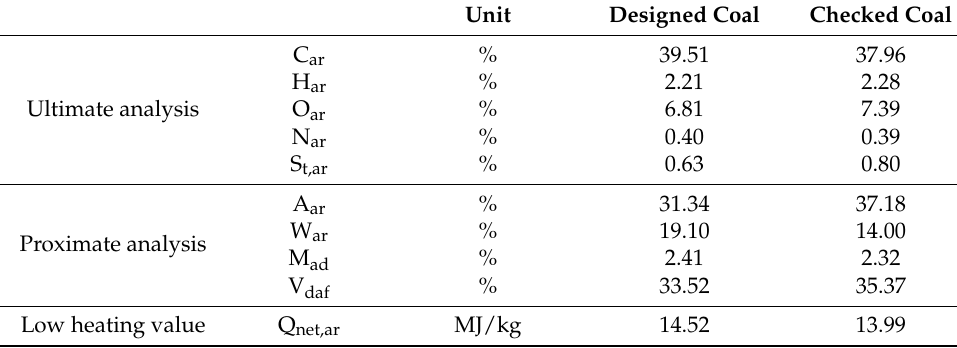
Figure 1. Schematic diagram of the 660 MW USC-CFB boiler. Table 1. Coal characteristics of the boiler.